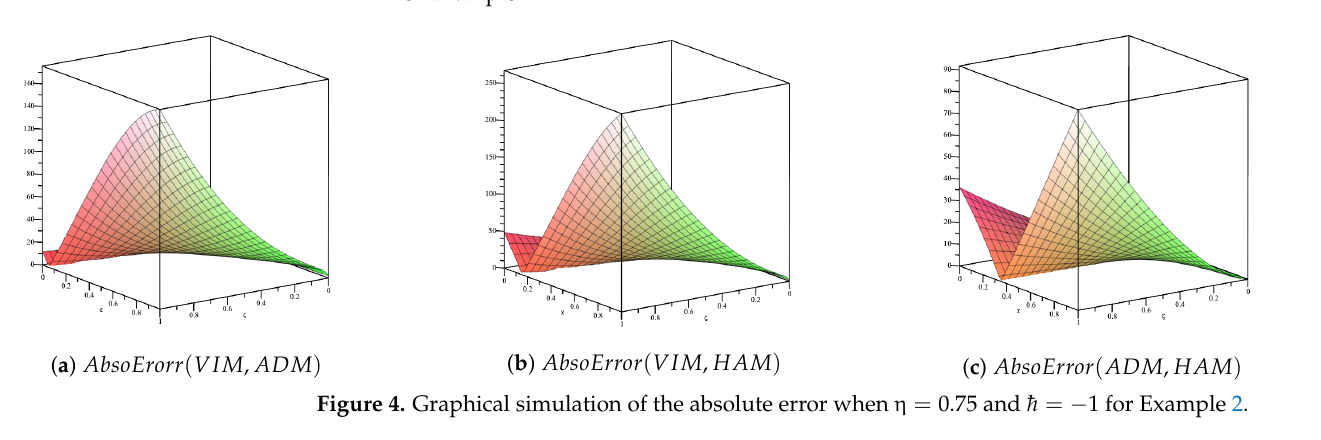
Figure 3. Graphical simulation of the first-level approximate solution ψ 1 ( χ , ζ ) when η = 0.75 and ¯ h = − 1 for Example 2.